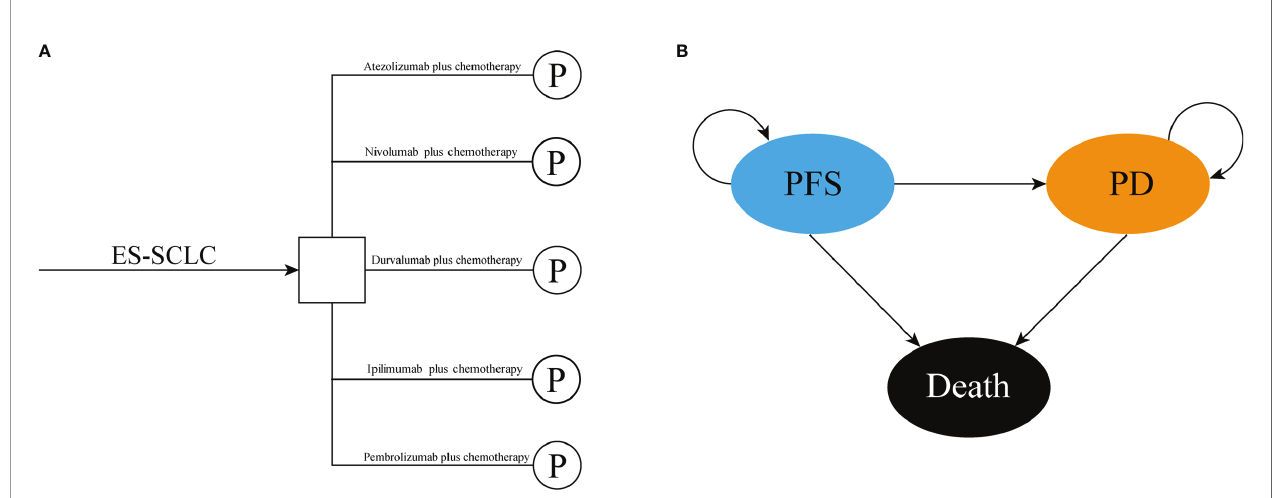
FIGURE 1 | The structure of the (A) decision tree and (B) partitioned survival model. ES-SCLC, extensive-stage small-cell lung cancer; PFS, progression-free survival; PD, progressed